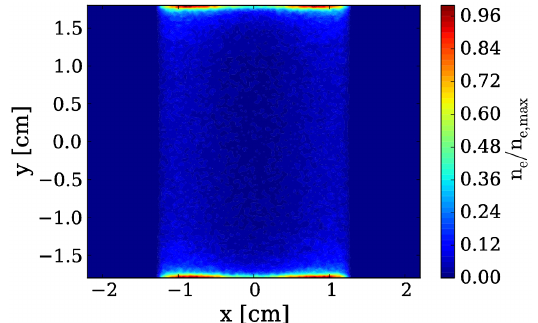
FIG. 17. Snapshot of electron cloud density 6 × σ bunch in the presence of an external magnetic field. The LHC pipe geometry is used. Bunch population is 10 11